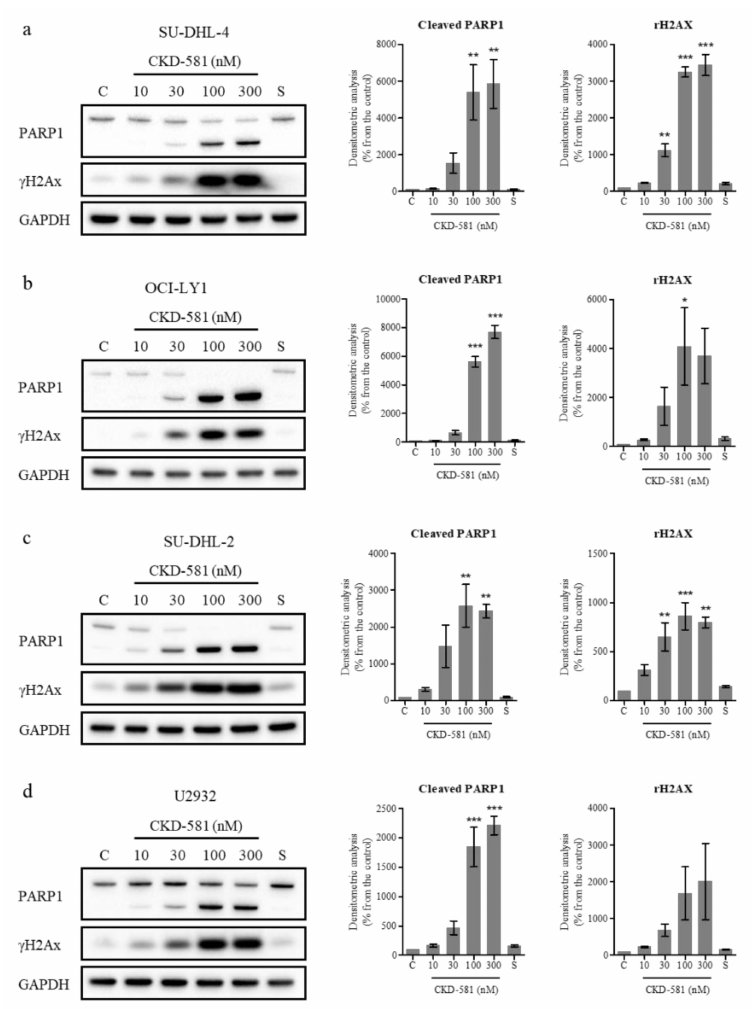
Figure 3. CKD-581 induces DNA damage and apoptosis. ( a ) SU-DHL-4, ( b ) OCI-LY1, ( c ) SU-DHL-2, and ( d ) U2932 cells were treated with vehicle control (C), CKD-581 (10–300 nM), or 300 nM SAHA (S) for 24 h, and total cell lysates were subjected to immunoblotting for γ H2AX and PARP1. Data represent mean ± SEM ( n = 3, significant vs. control; * p < 0.05, ** p < 0.01, *** p < 0.001). BCL- X L and MCL-1 are anti-apoptotic members of the BCL-2 family which are amplified in